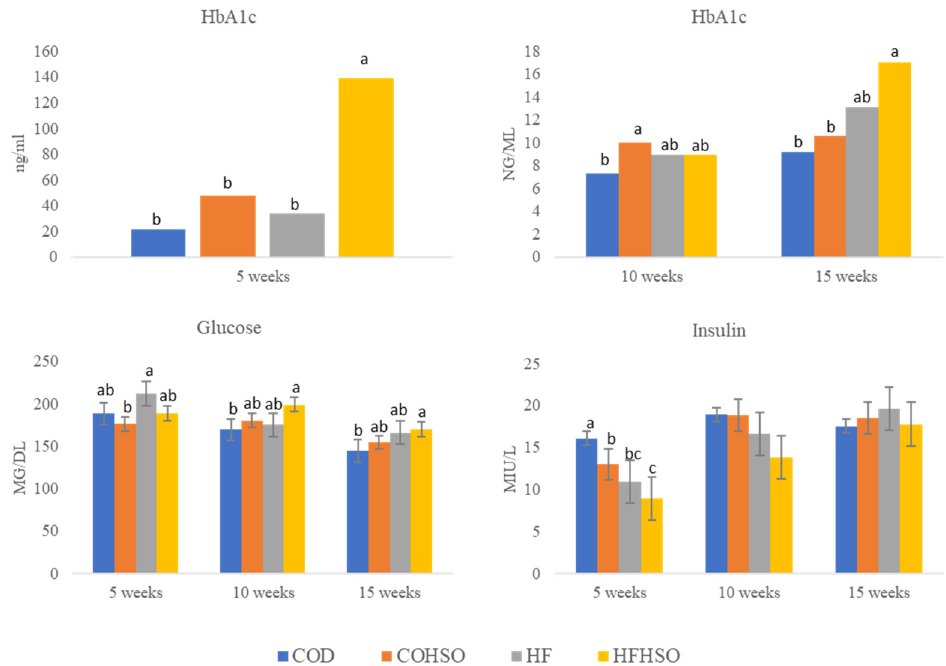
Figure 3. Pancreas function for rats. Significant p ≤ 0.05, a: the most significant result. All groups were compared with each other within the same week. The same bar with different superscript letters is significantly different among groups within the same week ( p < 0.05). COD: control diet, COHSO: control diet supplemented with 10% HSO, HF: high-fat diet, HFHSO: high-fat diet supplemented with 10% HSO, HSO: hemp seed oil.